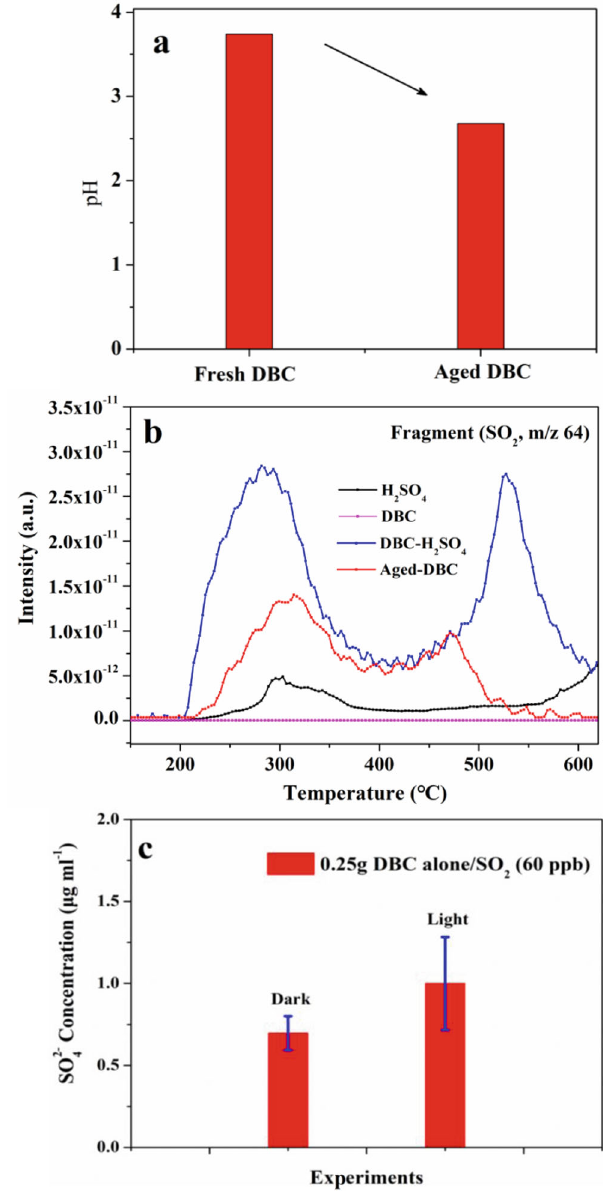
Fig. 2 | Characterization of H 2 SO 4 on DBC surface. pH values of fresh DBC and SO 2 -aged DBC ( a ). Evaluation and comparison of sulfur-containing fragments ( b ). The comparison of captured gaseous H 2 SO 4 underdarkand light irradiation. Error bars represent standard deviation ( c